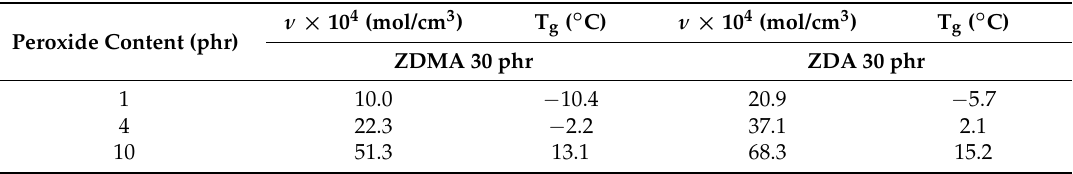
Figure 17. Variations of tan δ of composites cured with different content of peroxide. Table 5. Dependences of glass transition temperature T g and cross-link density ν of composites on the amount of dicumyl